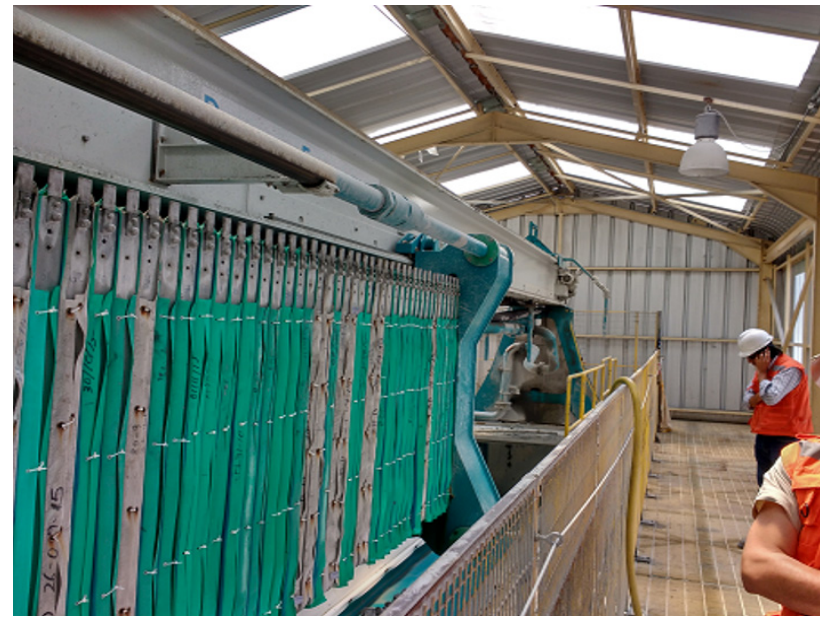
Figure 40. Tambo de Oro Tailings Vertical Plate Filter Press [49].